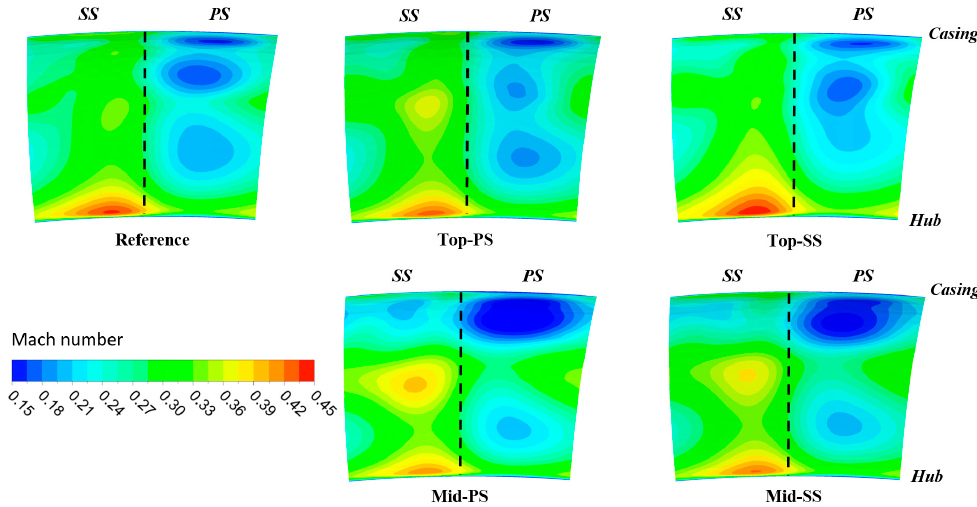
Figure 6. Mach number contours at entrance of S2 vane under different damaged-blade conditions.